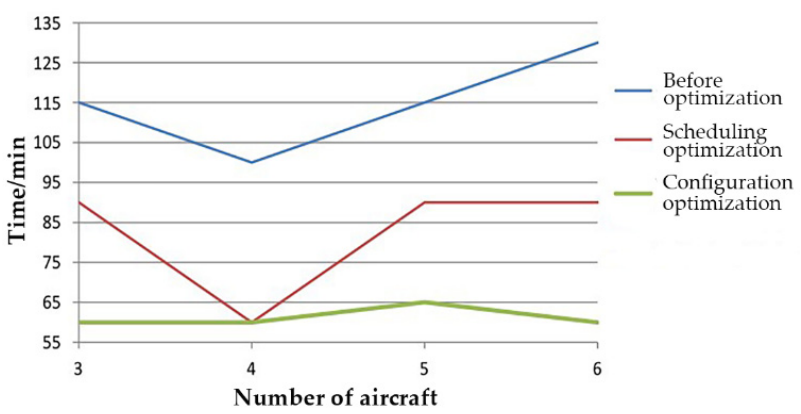
Figure 12. Multi-aircraft support three times.